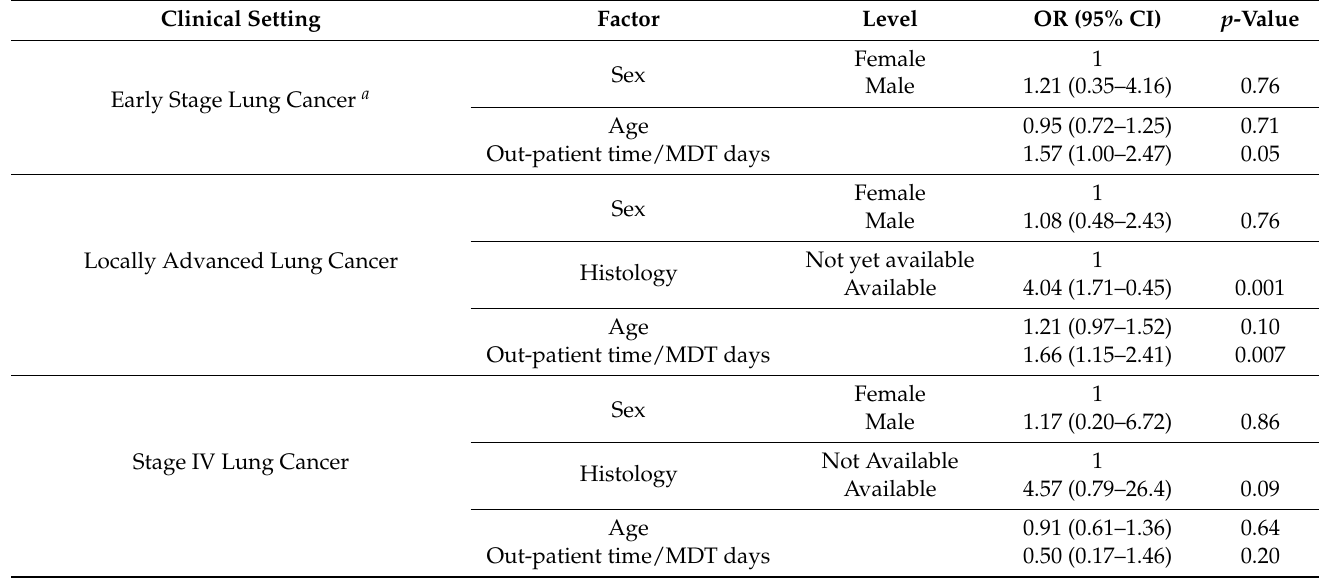
Table 4. Univariate Analysis of factors associated with modification by clinical setting. Clinical